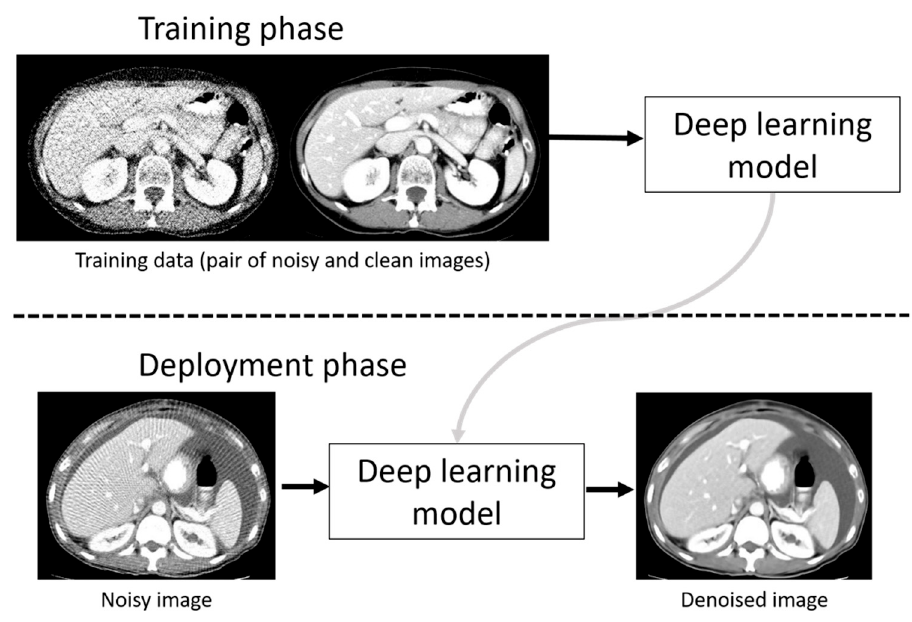
Figure 1. Outline of the training phase and deployment phase of the deep learning model.